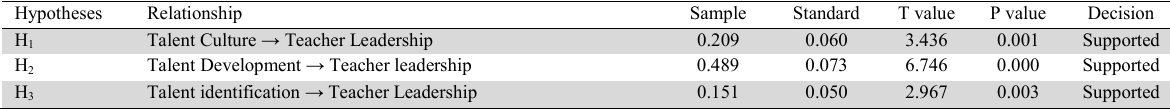
Parameter estimates (structural model)